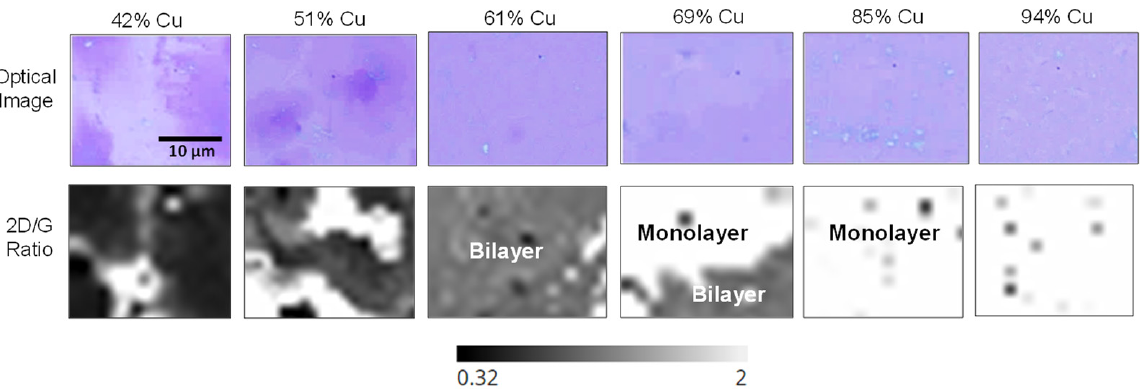
Figure 5. Optical images of graphene were transferred to a Si wafer which was grown on the Cu x Ni 1 − x gradient catalyst (42–94 at.% Cu) ( top row ). Raman maps report the 2D/G ratio of the transferred graphene. Maps correspond to the optical images ( bottom row ).